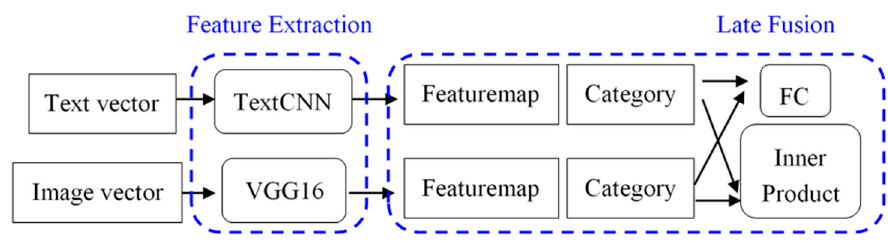
Figure 4. The architecture for late fusion of text and image features.